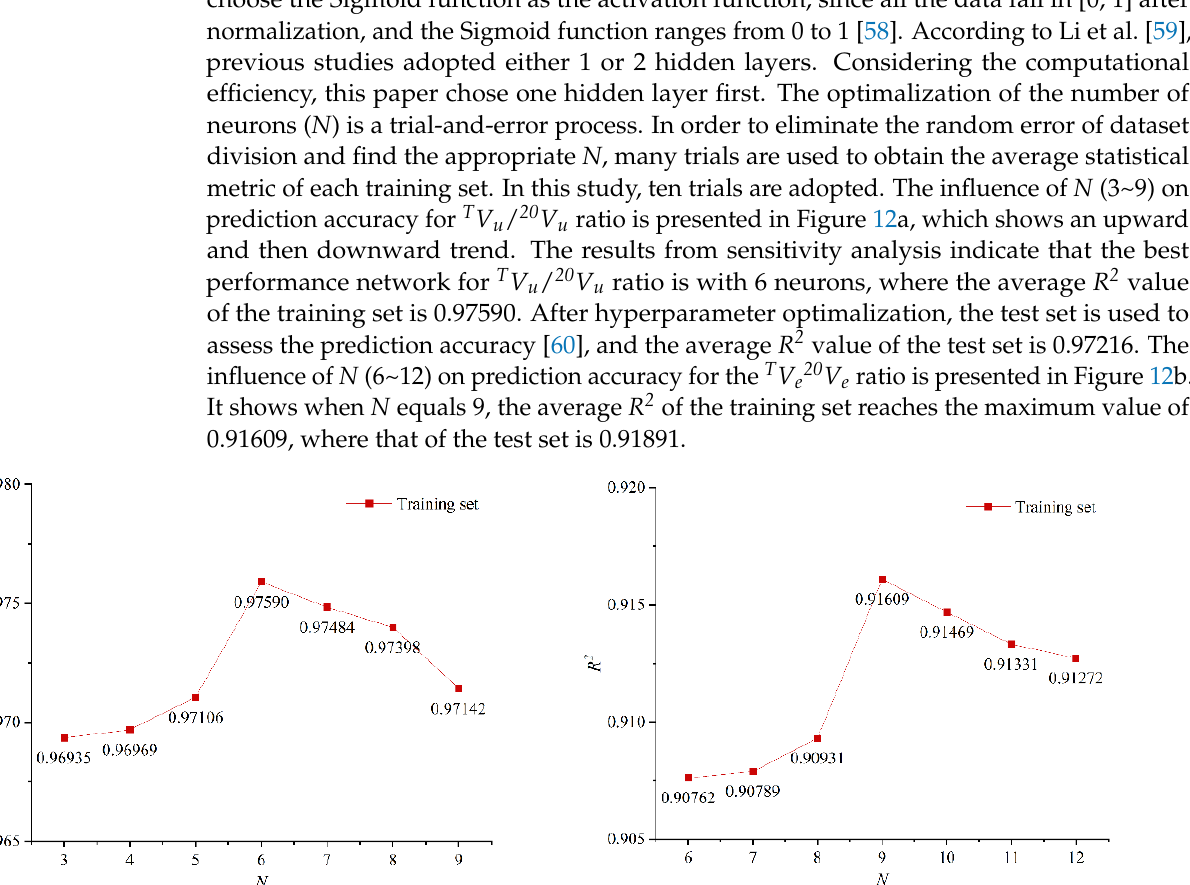
Figure 12. Influences of the number of neurons ( N ) on R 2 on the training set. ( a ) T V u / 20 V u ratio; ( b ) T V e / 20 V e